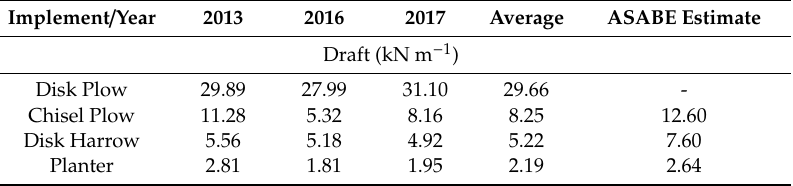
Table 4. Draft for each implement used in the tillage systems.